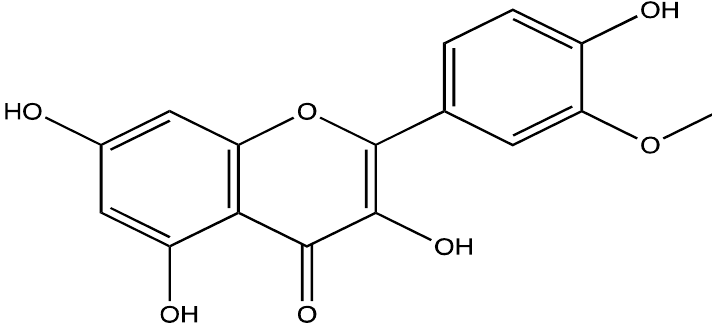
Figure 11. Structure of isorhamnetin isolated from H. rhamnoides .